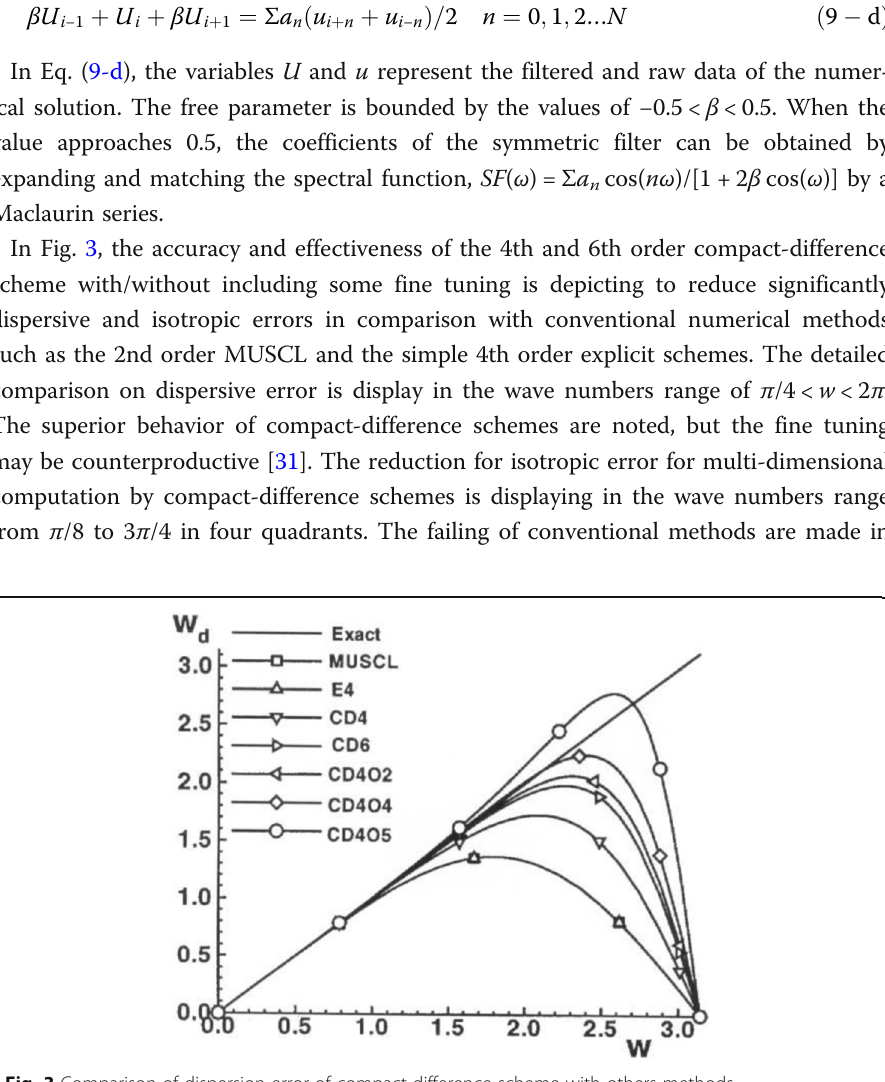
Fig. 3 Comparison of dispersion error of compact-difference scheme with others